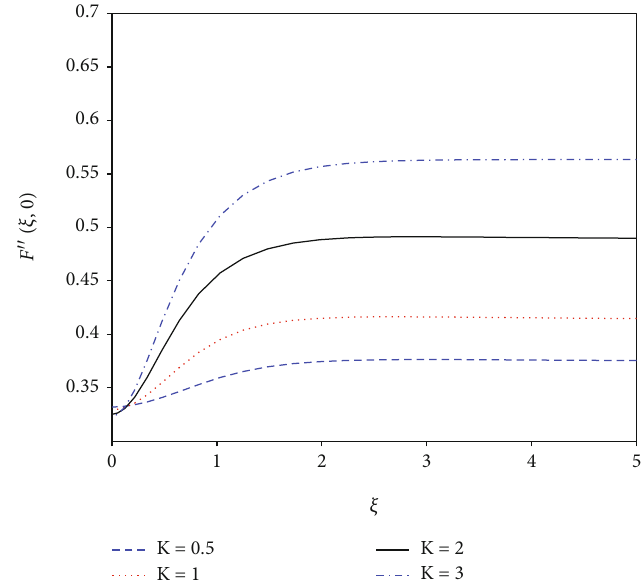
Figure 14: Development of the wall shear stress F ′′ ð ξ , 0 Þ for di ff erent values of vortex viscosity parameter K , when n = 1, ξ = 5, Pr = 10, and S = Ω = N = He = 0 R